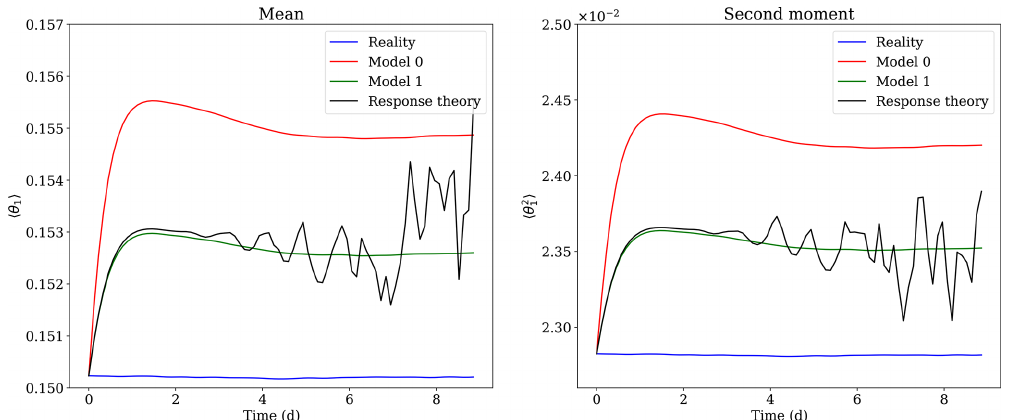
Figure 6. Corrections of the moments of θ 1 from model 0 to model 1 using the response-theory formula of Eq. (49), for the experiment with a modification of the Newtonian cooling